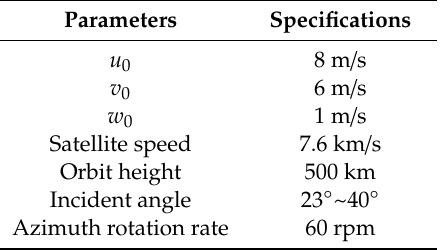
Table 1. Parameters for simulation.